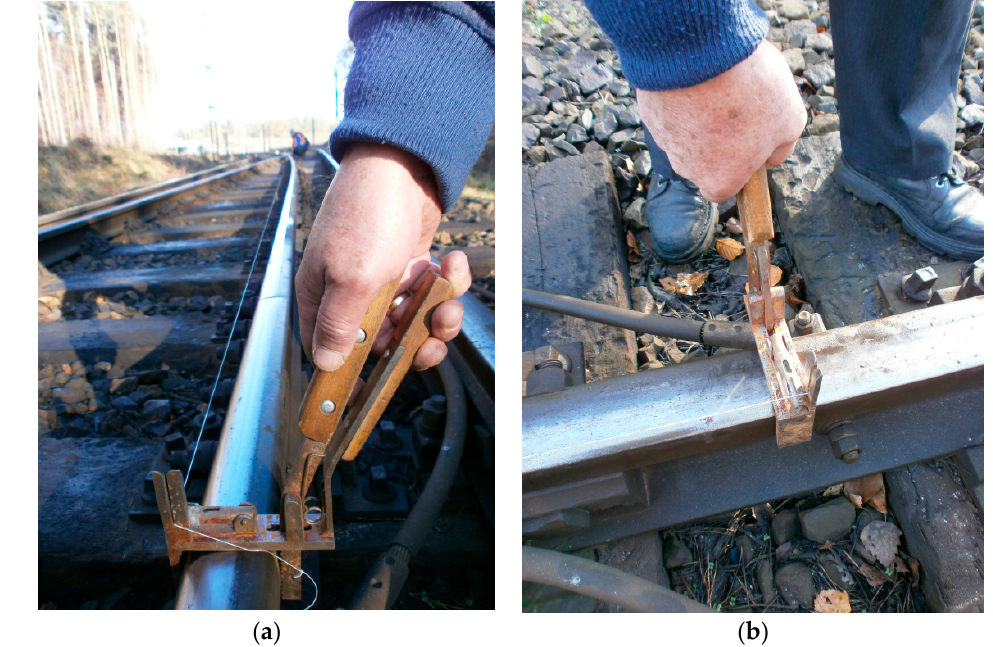
Figure 7. The Versine Measuring Device (VMD), as a regular device used so far) (own photograph): ( a ) the VMD—side view; ( b ) the VMD—overhead view.